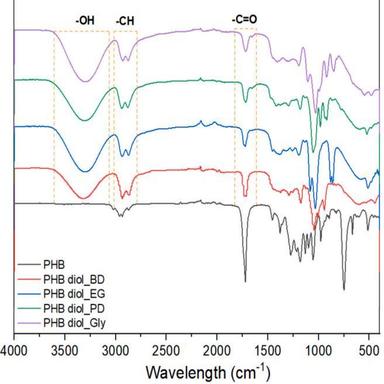
FT-IR spectra of PHB granule and PHB-diol samples obtained via transesterification with different alcohols.